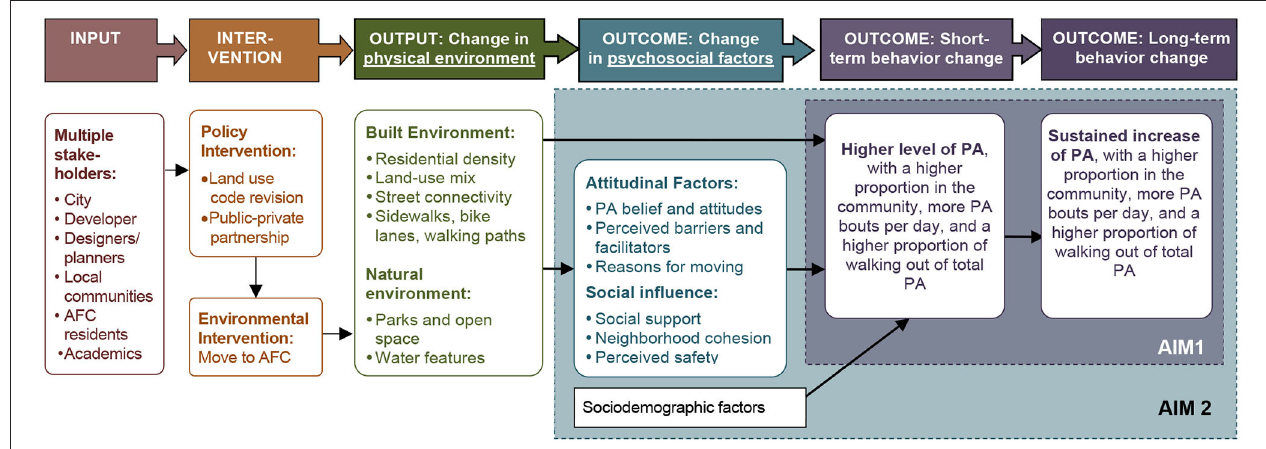
FIGURE 1 | Logic model for the Active Living Austin